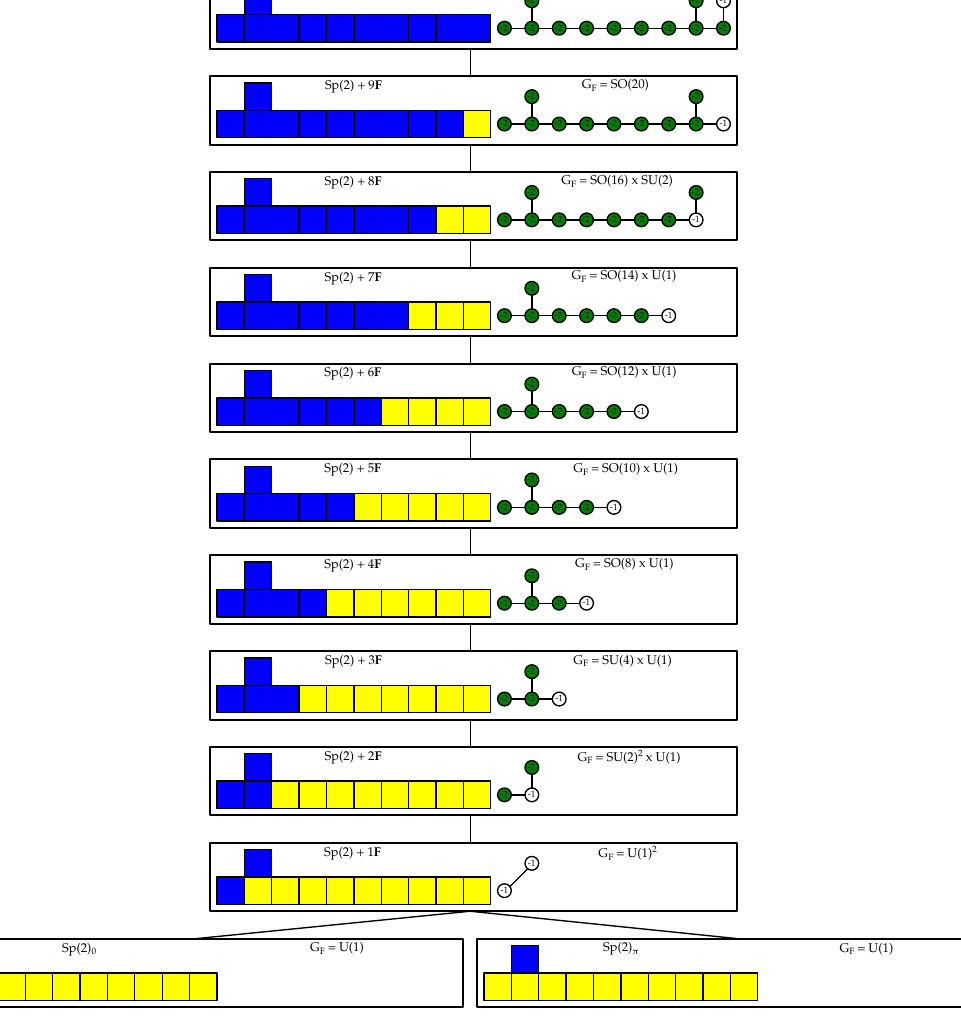
Figure 34. ( D 5 ; D 5 ) Conformal Matter: marginal theory description as Sp(2) + 10 F . The (cid:12)gure shows the tree of descendant theories, together with their superconformal (cid:13)avor symmetry, G F